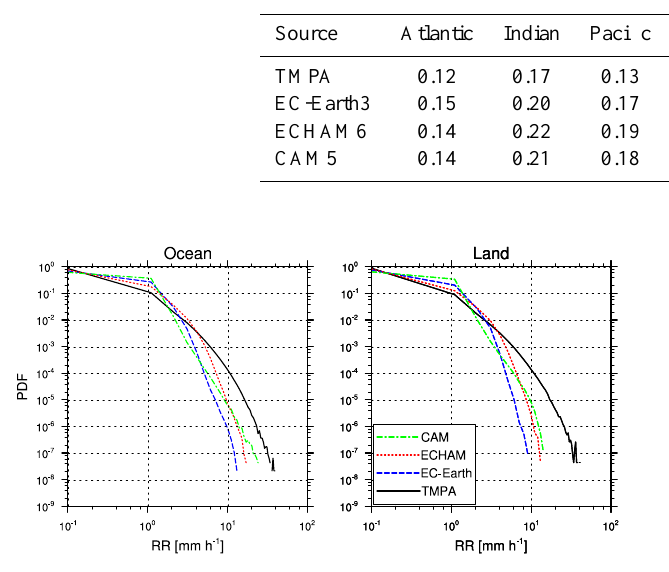
Figure 2. Normalised probability density function of surface rain rates for ocean-based (left plot) and land-based (right plot) regions for total precipitation of the merged regions described in Fig.